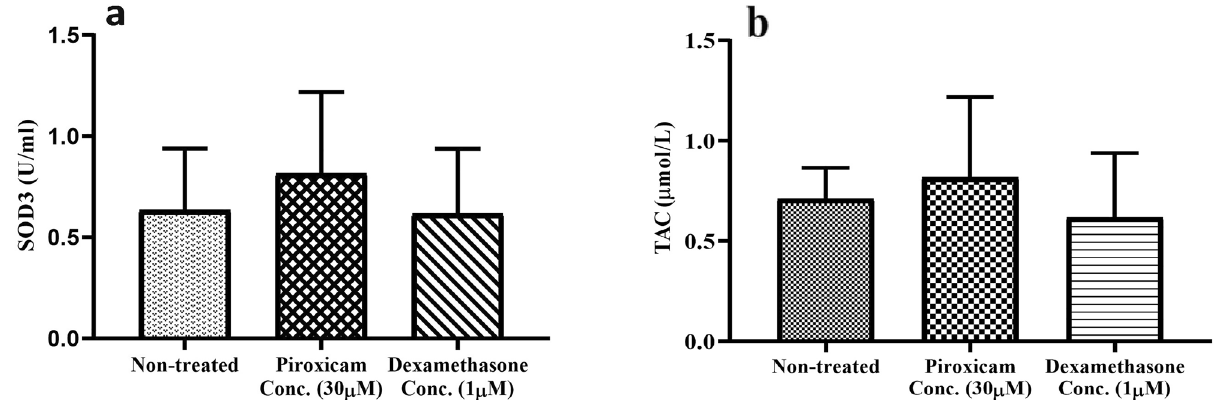
Figure 6. The effect of drugs on the oxidative activity of T cells in PBMCs. The effect of dexamethasone and piroxicam was measured on the SOD3 activity ( a ) and TAC levels ( b ) of T cells in PBMCs (n = 3). The graphs show the mean ± SD. Significant changes are indicated with asterisk (* p < 0.05, ** p < 0.01, *** p < 0.001, **** p < 0.0001).